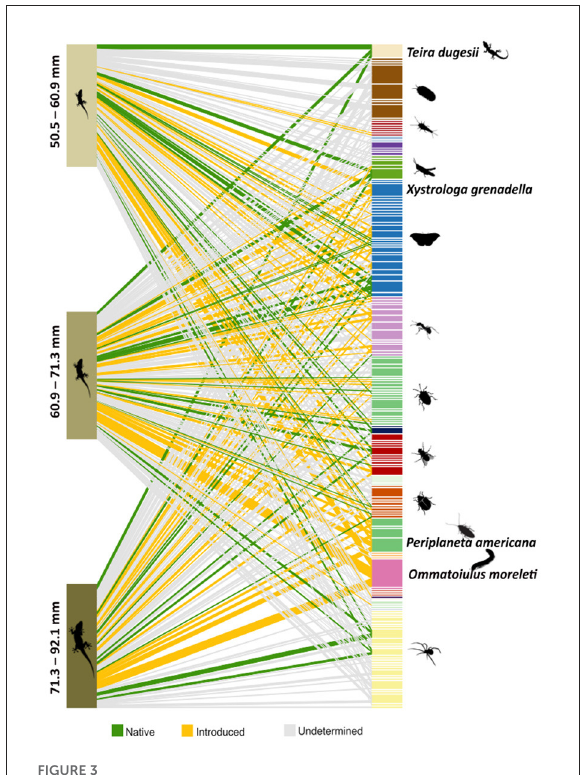
FIGURE3 Frequency of occurrence network showing the Operating Taxonomic Units (OTUs) ingested by the different size classes of Tarentola mauritanica . Size interval (in mm) of each class is represented to the left of the figure. White lines separate the different OTUs, and the colouration is according to their taxonomic Order. The figure also depicts the most consumed introduced species ( Ommatoiulus moreleti , Periplaneta Americana , and Xystrologa grenadella ), and families (Porcellionidae, Formicidae, and Julidae).